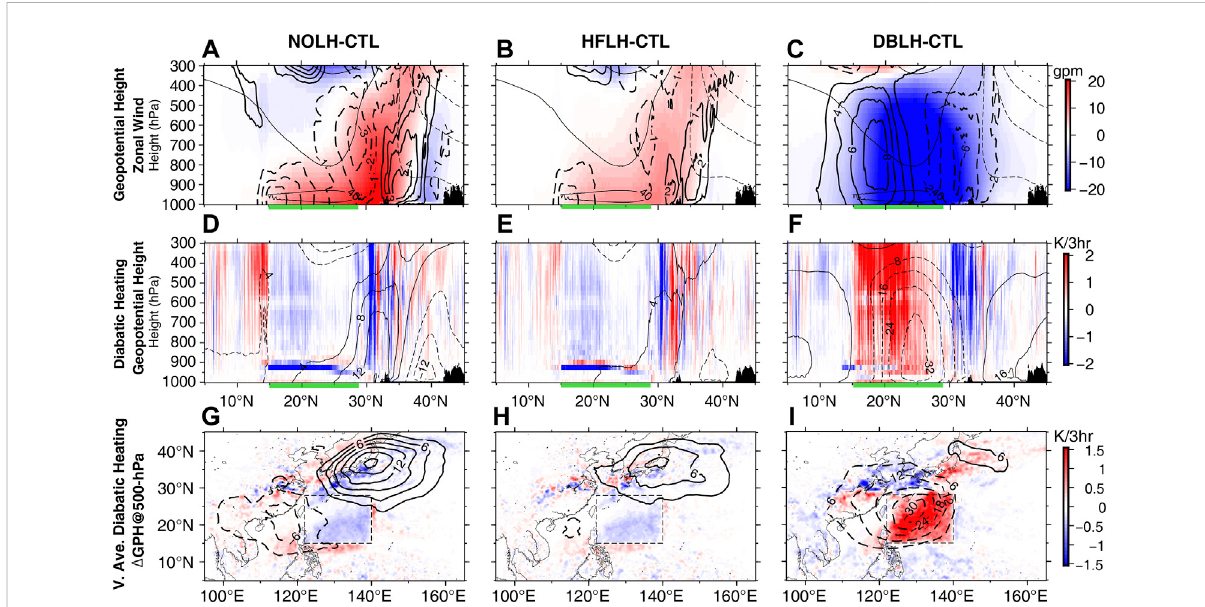
FIGURE 9 Cross-sectionsalong130 ° E: (A – C) ofthegeopotentialheight(colorshading)andzonalwindanomalies(thickcontoursofevery1 m/s;eastward positive) and (D – F) diabatic heating (color shading) and geopotential height anomalies (contour). (G – I) Horizontal distributions of the vertically averaged diabatic heating (1000- to 300-hPa) and wind anomalies at the 500-hPa level. Geopotential height in the CTL run is also plotted by thin contours with every 40-gpm in (A – C) . Contour intervals are doubled in (C,F,I) to avoid